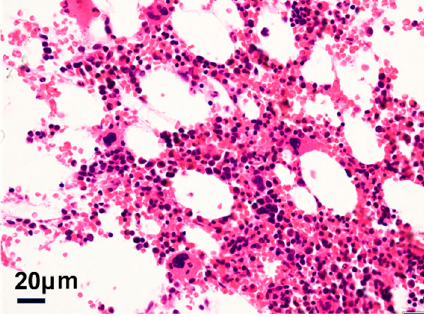
Figure 4. Pathology of bone marrow sampled at the same time as the breast cancer surgery. Histo- logical examination of the bone biopsy tissue shows no malignant